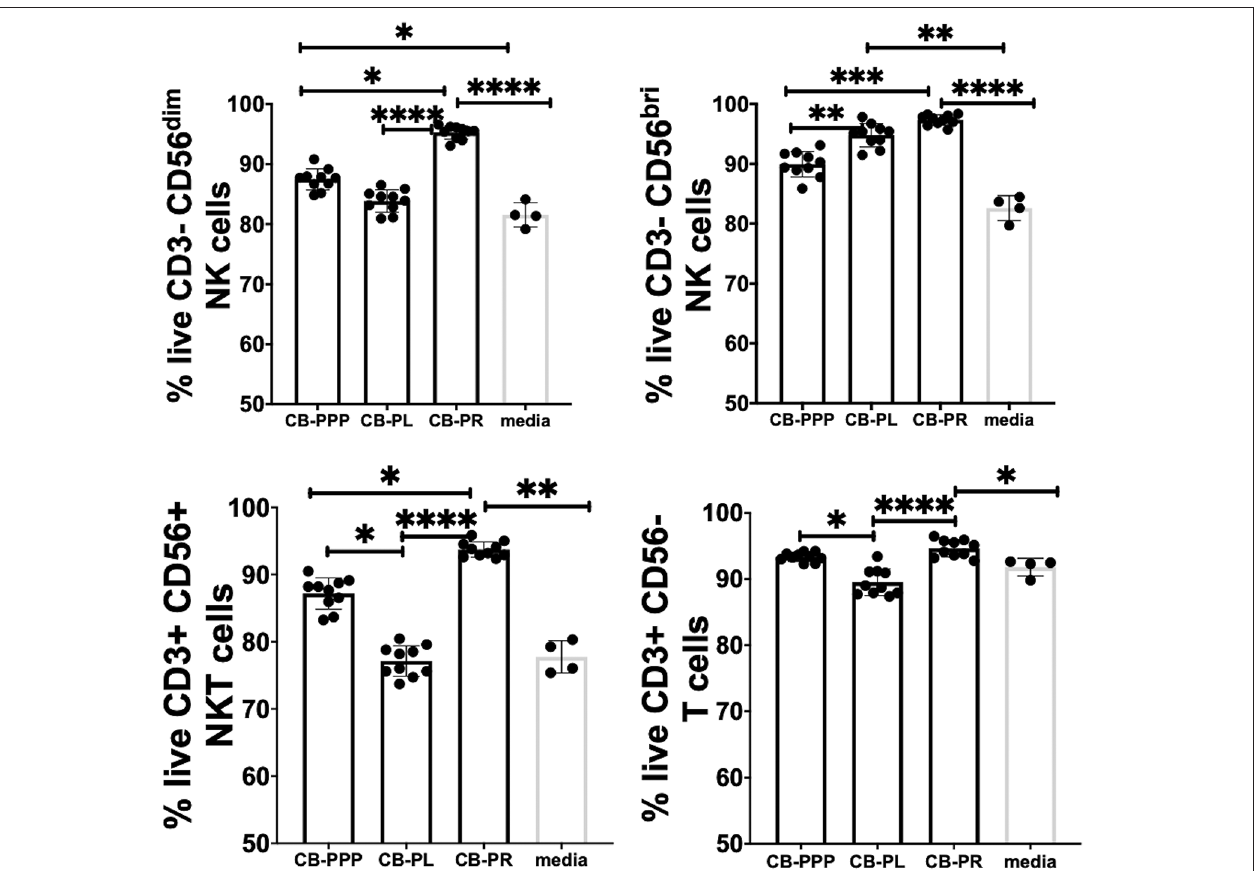
FIGURE 3 | Viability of CD3- CD56 dim, CD3- CD56 bright NK cells, CD3 + CD56 + NKT cells, and CD3 + CD56- T cells from adult donor PBMCs ( n = 3) after incubation with cord blood plasma preparations or complete media only. Results show percentage of live cells (Annexin V negative, 7-AAD negative) for each cell type. Cord blood plasma preparations investigated were cord blood platelet poor plasma (CB-PPP; n = 10), cord blood platelet lysate (CB-PL; n = 10), or cord blood platelet releasate (CB-PR; n = 10). PBMCs were incubated with each preparation diluted 50:50 with media and supplemented with IL-2, or with complete media and IL-2 only for 48h prior to antibody staining and flow cytometry analysis. Each experiment was repeated with four different PBMC donors and data points represent donor means. Statistical analysis was performed using non-parametric one-way ANOVA (Kruskal-Wallis test with Dunn’s post-hoc test for unpaired samples and Friedman’s for paired samples). * p < 0.05, ** p < 0.01, *** p < 0.001, **** p <